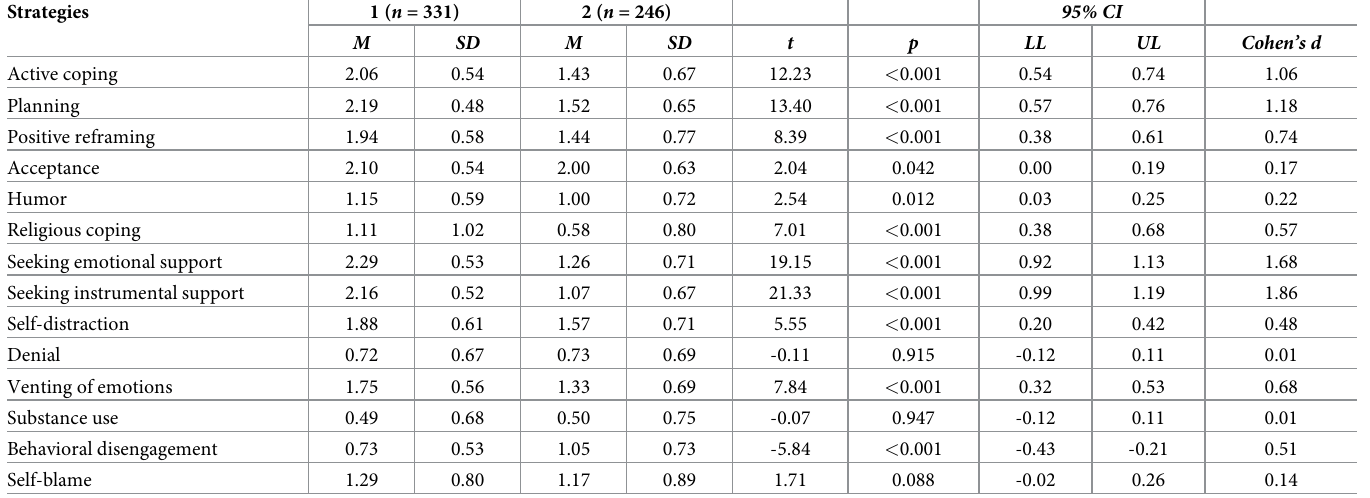
Table 5. Comparisons of coping strategies between the